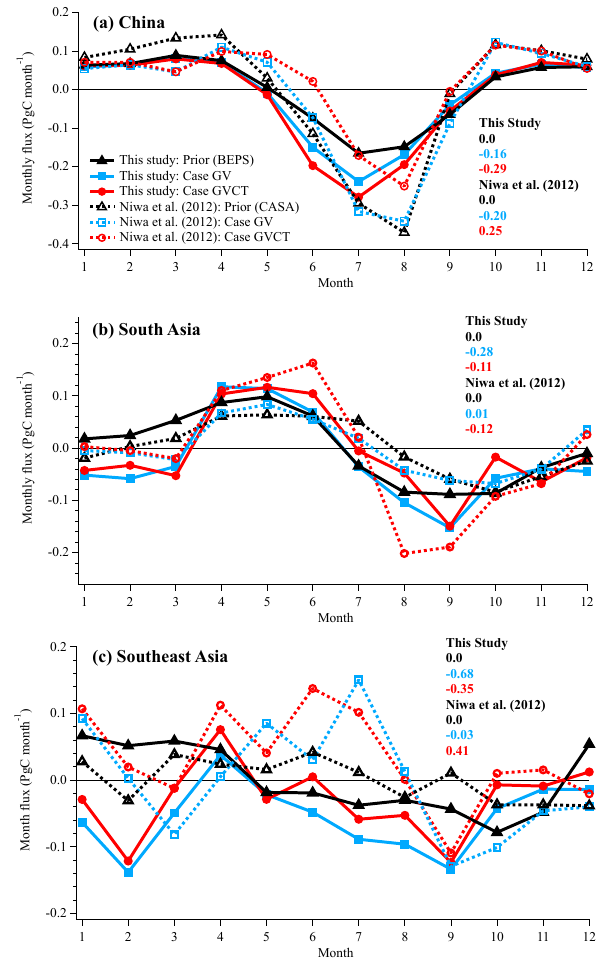
Figure 7. Mean monthly fluxes in (a) China, (b) South Asia and (c) Southeast Asia during 2006–2008 (Case GV: only constrained by GV CO 2 ; Case GVCT: constrained by both GV CO 2 and CON- TRAIL CO 2 )